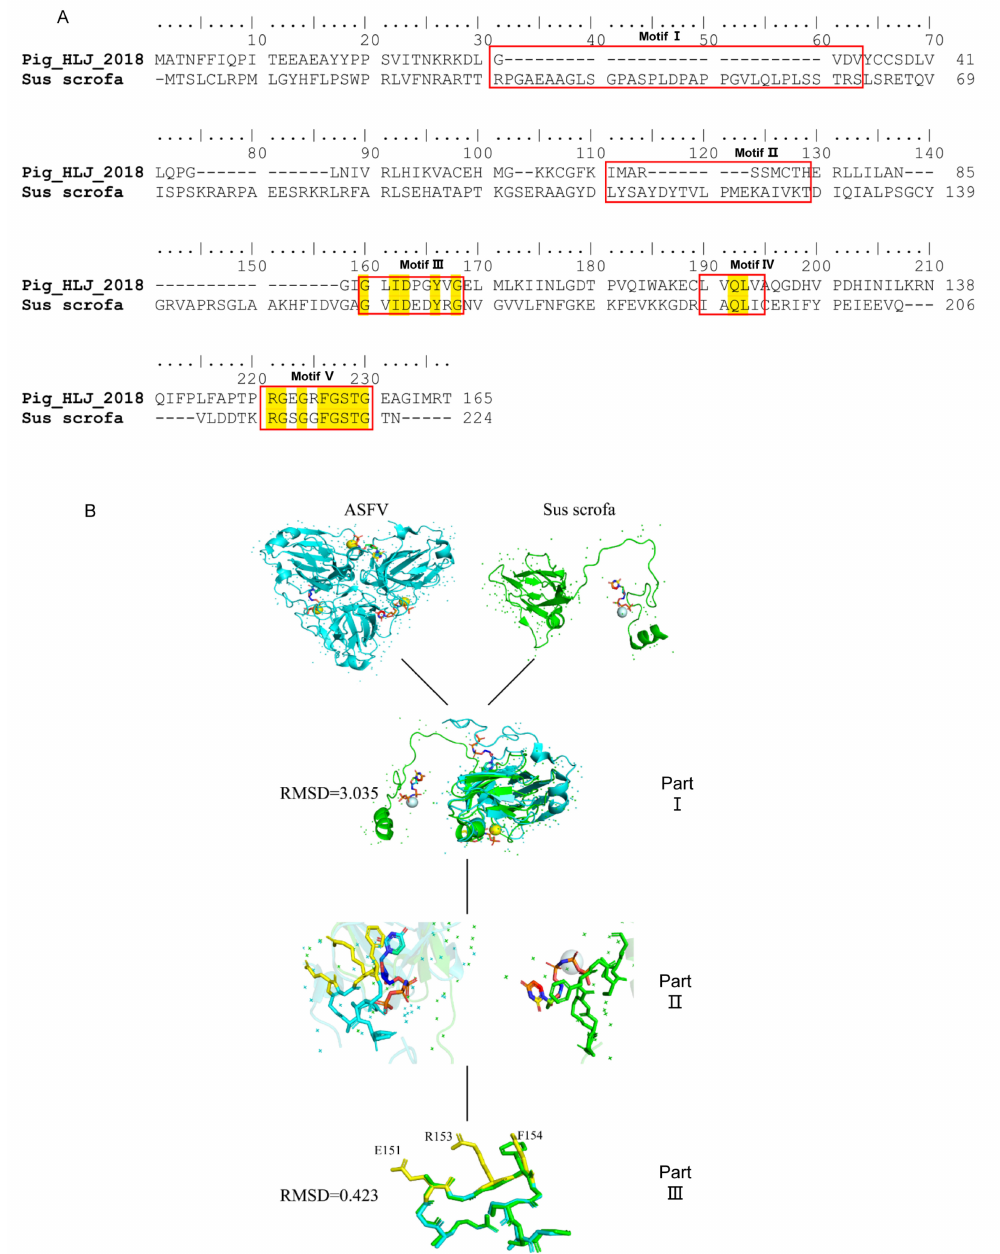
Figure 6. Specificity of 8F9 mAb in epitope recognition. ( A ) Amino acid sequence alignment of dUTPase from ASFV and Sus scrofa, where motif regions of dUTPase are highlighted in red, identical amino acid residues are highlighted in yellow. ( B ) Structure comparison of ASFV E165R with Sus scrofa dUTPase in complex with substrates. Part II: protomer of ASFV E165R is compared with that of Sus scrofa dUTPase. Part II: relative position amplification of neutralizing epitope of 8F6 mAb in part II. Part III: position of 8F6 mAb neutralizing epitope for ASFV E165R compared with that of Sus scrofa; amino acids with structural differences are highlighted in yellow. The ASFV E165R and Sus scrofa dUTPase protomers are colored in sky blue and green, respectively. ‘+’ denotes